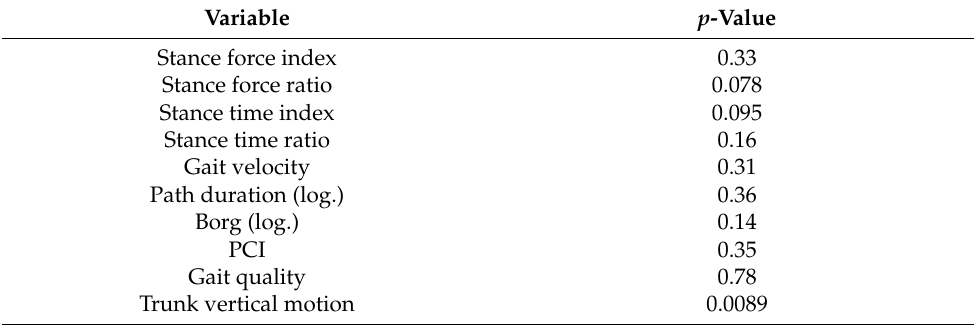
Table 2. ANOVA results.